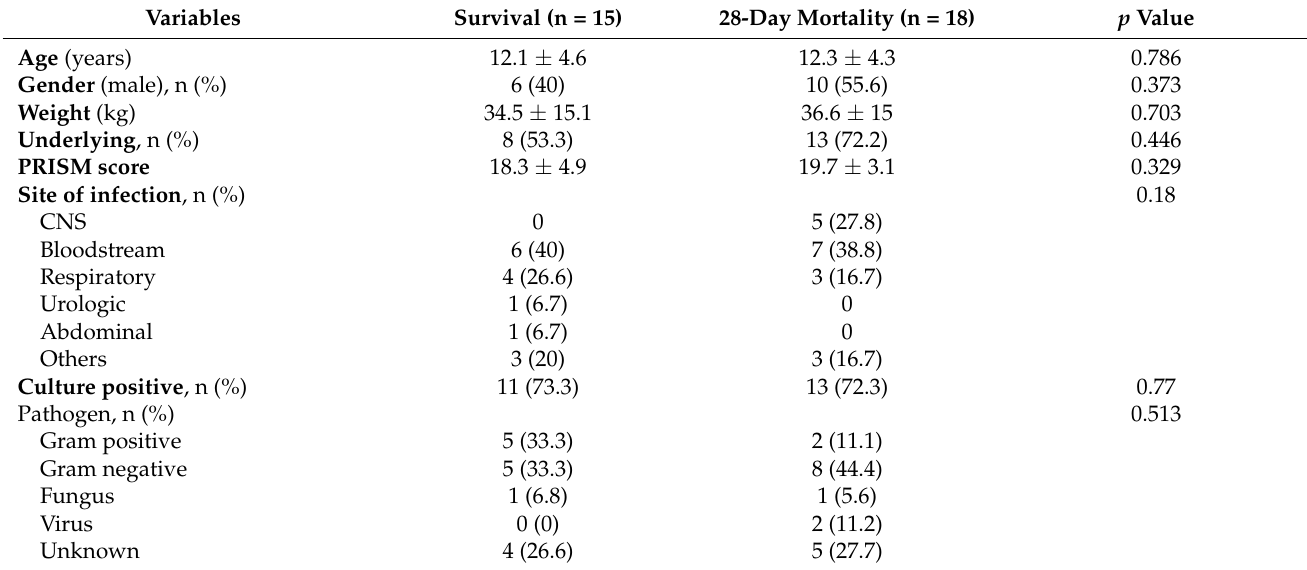
Table 1. Population characteristics and initial PiCCO parameters.